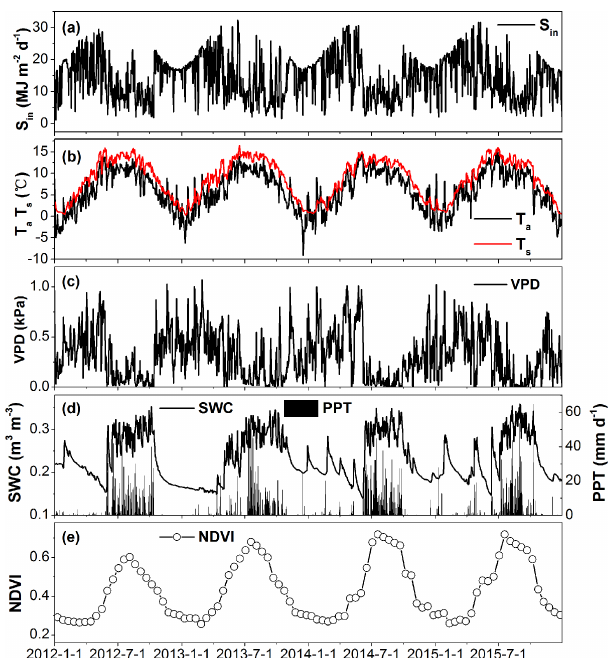
Figure 1. (a) Daily sum of solar radiation ( S in ) , (b) daily mean air temperature ( T a ) , soil temperature ( T s ) , (c) vapour pressure deficit (VPD, 5cm), (d) soil water content (SWC, 5cm), daily total precip- itation (PPT) and (e) 16-day average normalized difference vegeta- tion index (NDVI) from 2012 to 2015.